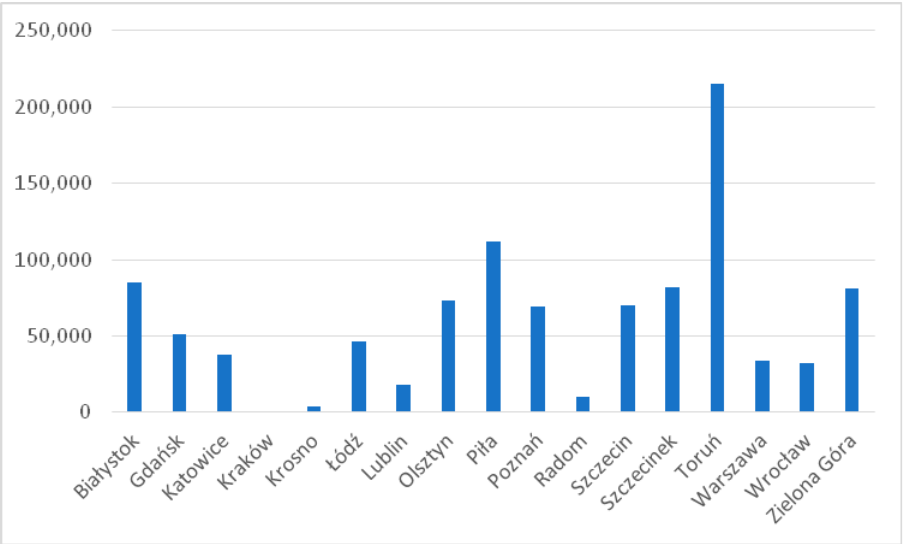
Figure 3. The volume of forest biomass harvested for energy purposes in 2020 according to Re- gional Directorates of the State Forests [m 3 ]. Directorates of the State Forests [m 3